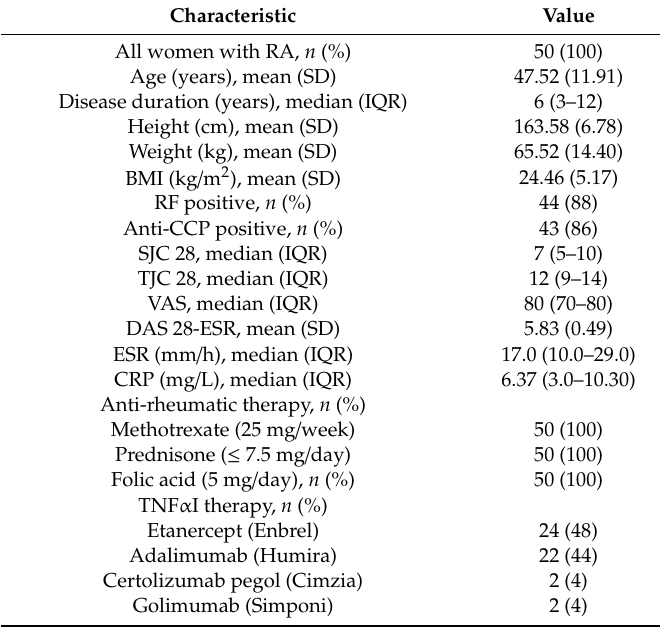
Table 1. Baseline characteristics of female RA patients treated with TNF- α